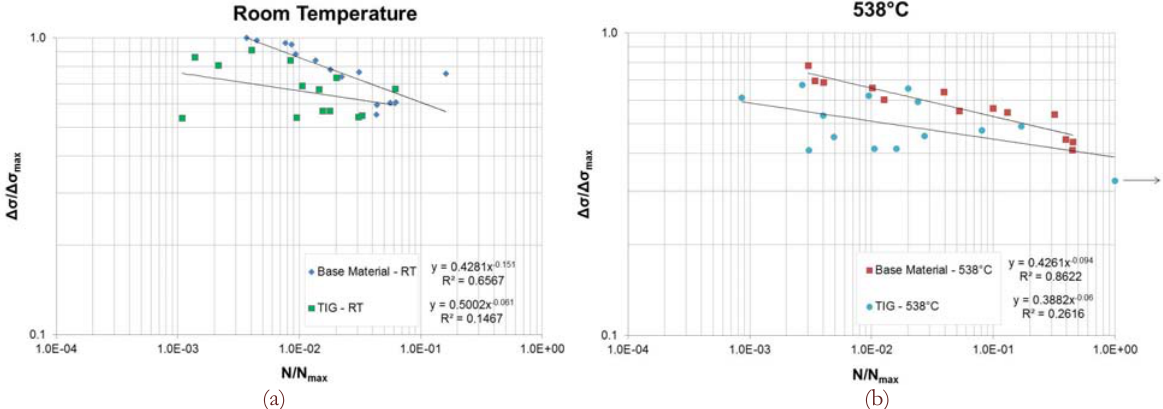
Figure 8: Comparison of fatigue curves in terms of measured stress range at RT (a) and 538°C (b).